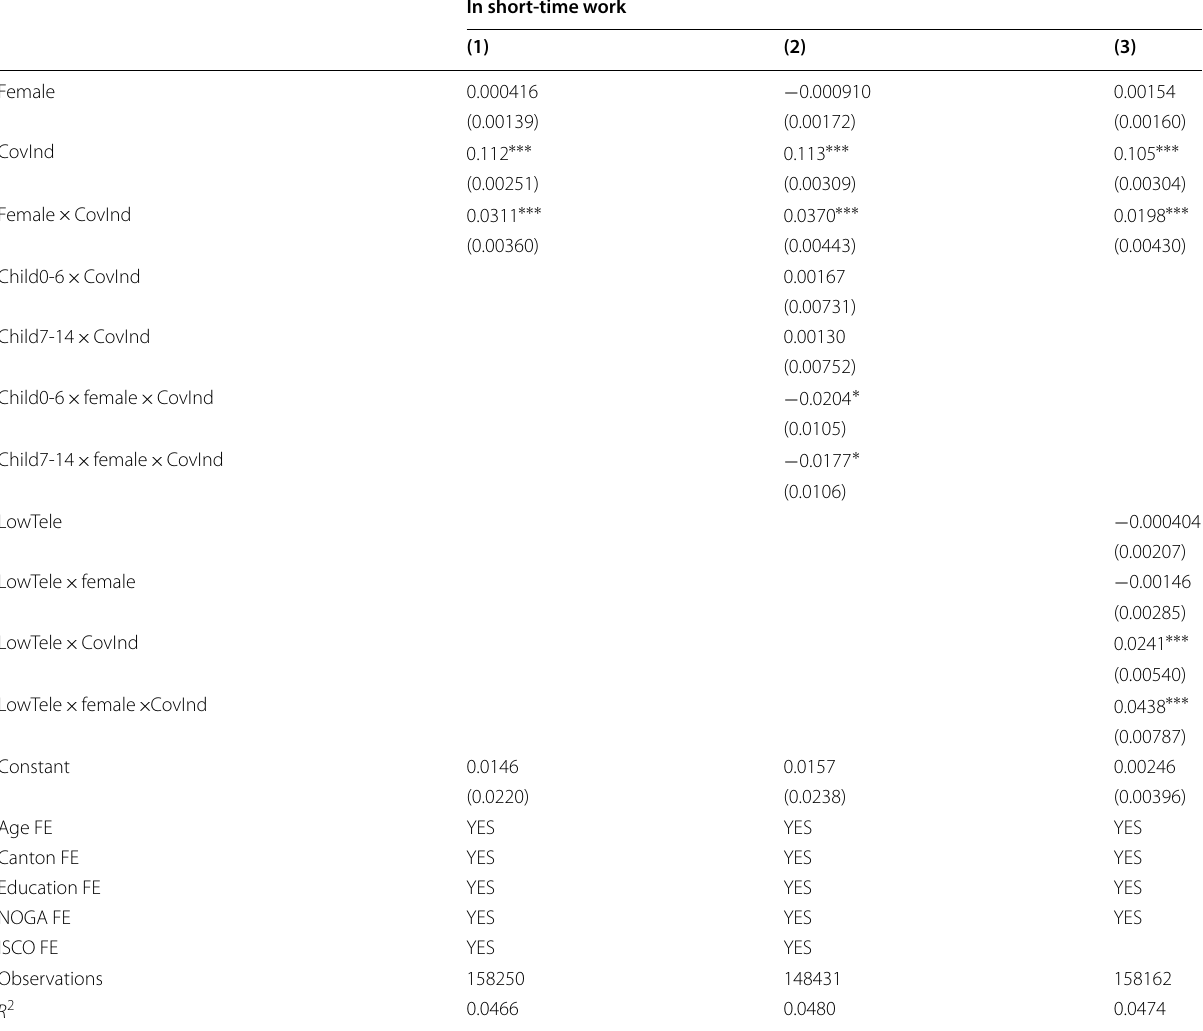
Table 7 The effect of COVID-19 and gender on